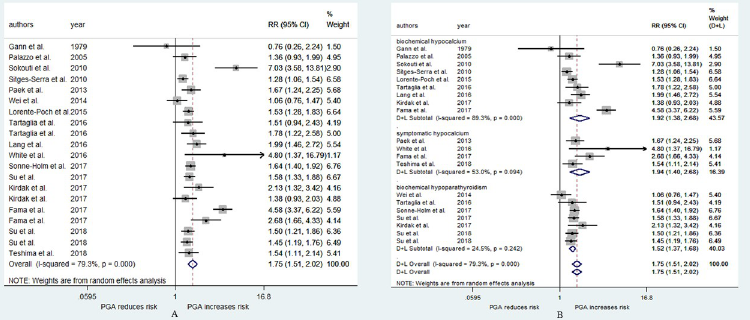
Fig 2. RR for postoperative hypoparathyroidism in patients who underwent PGA vs patients who not underwent PGA. (A) overall relative risks. (B) the relative risk in subgroup of different evaluation indexes.